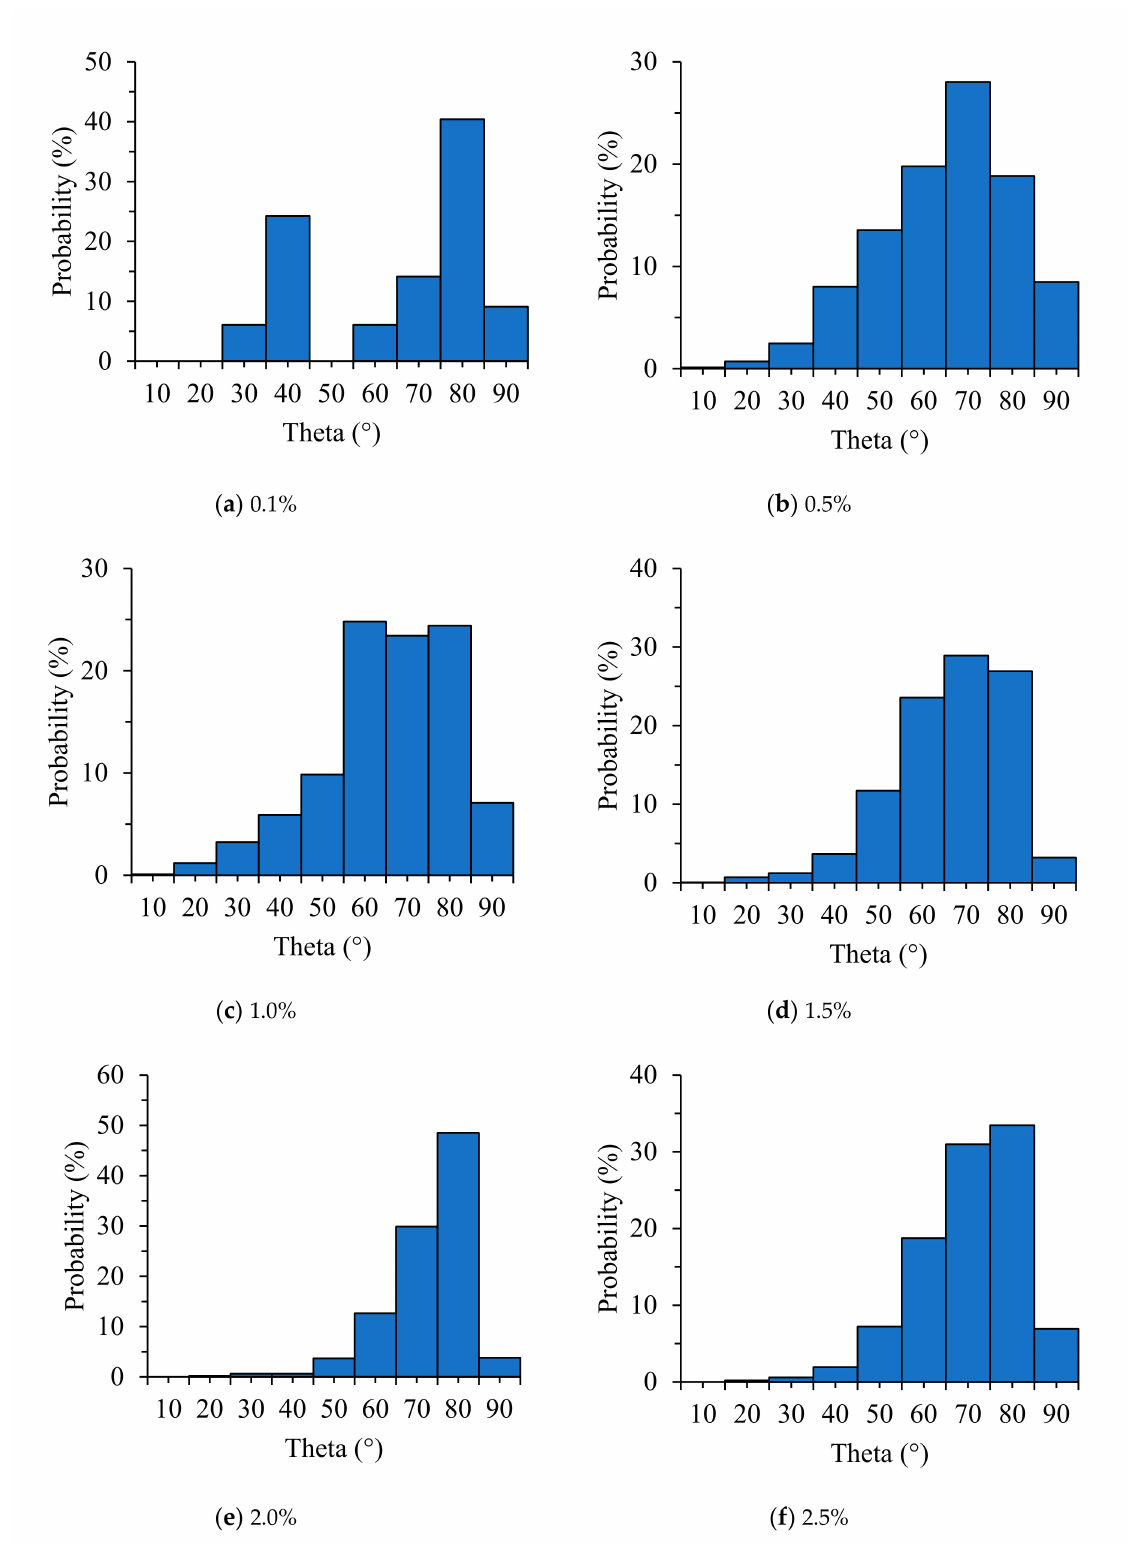
Figure 8. Probability density histograms of the polar angle θ for various fiber